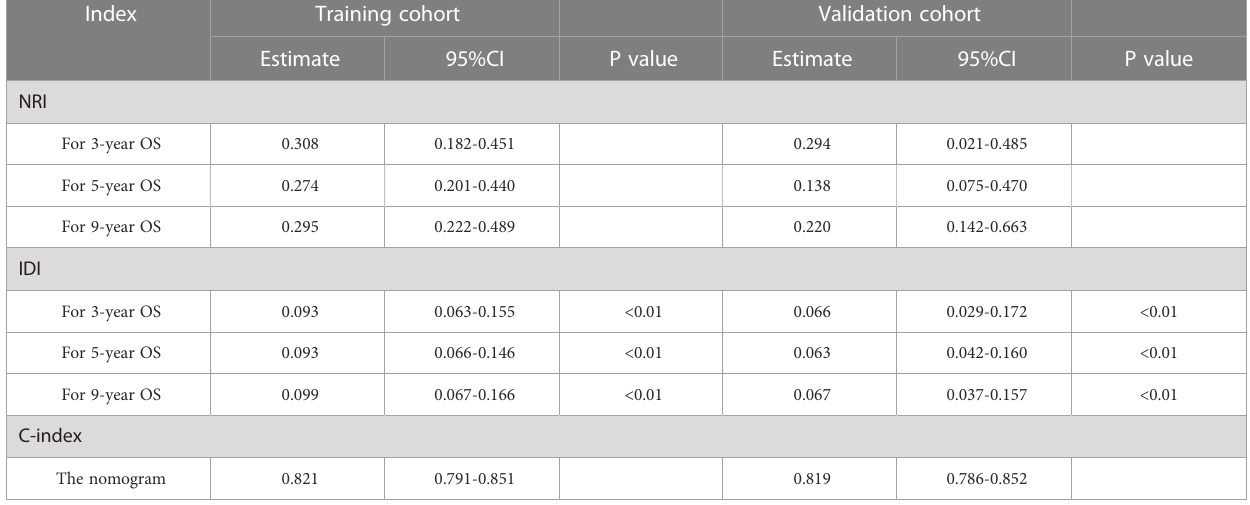
TABLE 3 the NRI and IDI values of 3-, 5-, and 9-year OS, with the C-index of nomogram in the training and validation